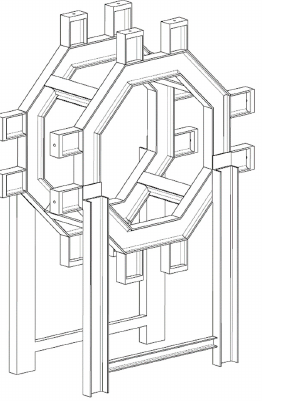
Figure 2. Main structure.